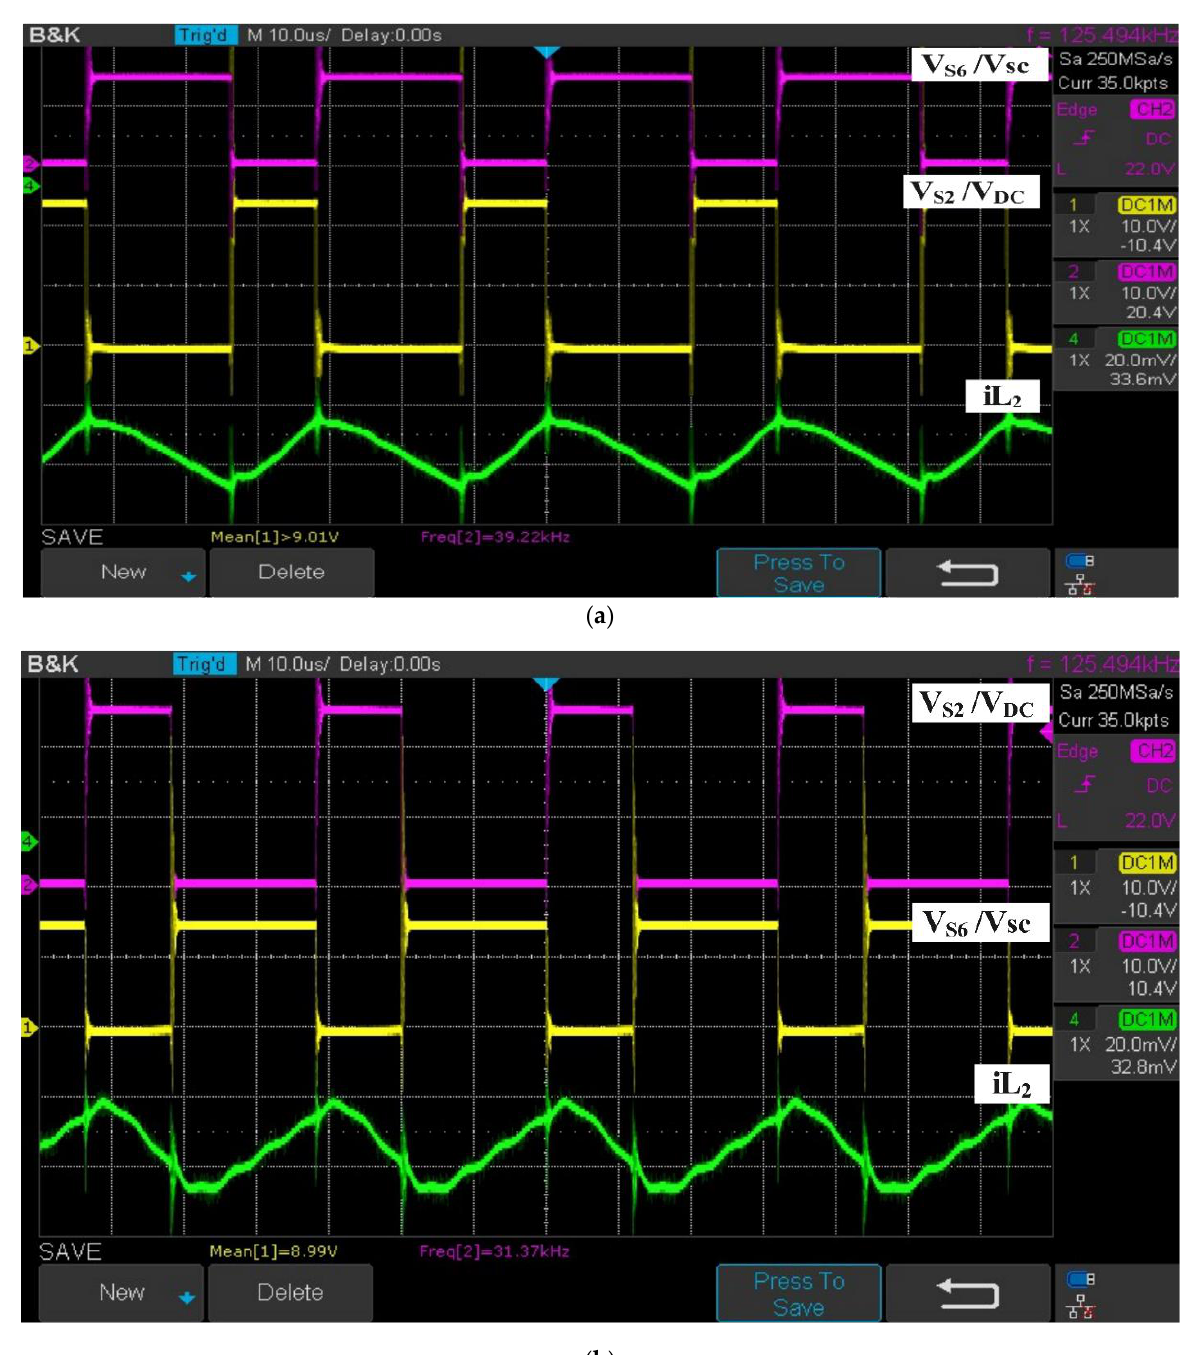
Figure 19. ( a ) Mode 2(a): charging and discharging of inductor L 2 . ( b ) Mode 2(b): charging and discharging of inductor L 2 . discharging of inductor L 2